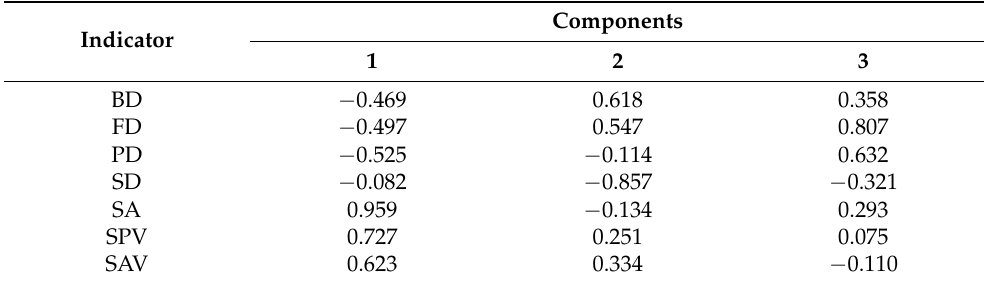
Table 6. Matrix of eye movement indicators